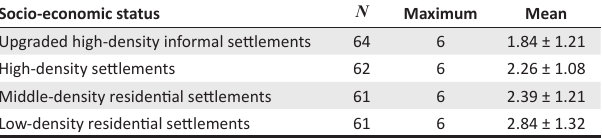
TABLE 4: Number of municipal-sized bags generated per household per week in Mthatha, South Africa ( N = 248). Socio-economic status